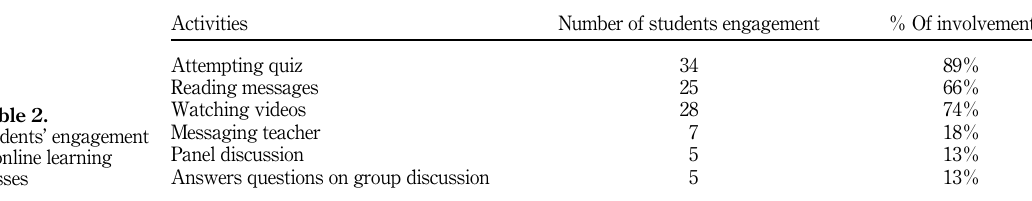
in online learning